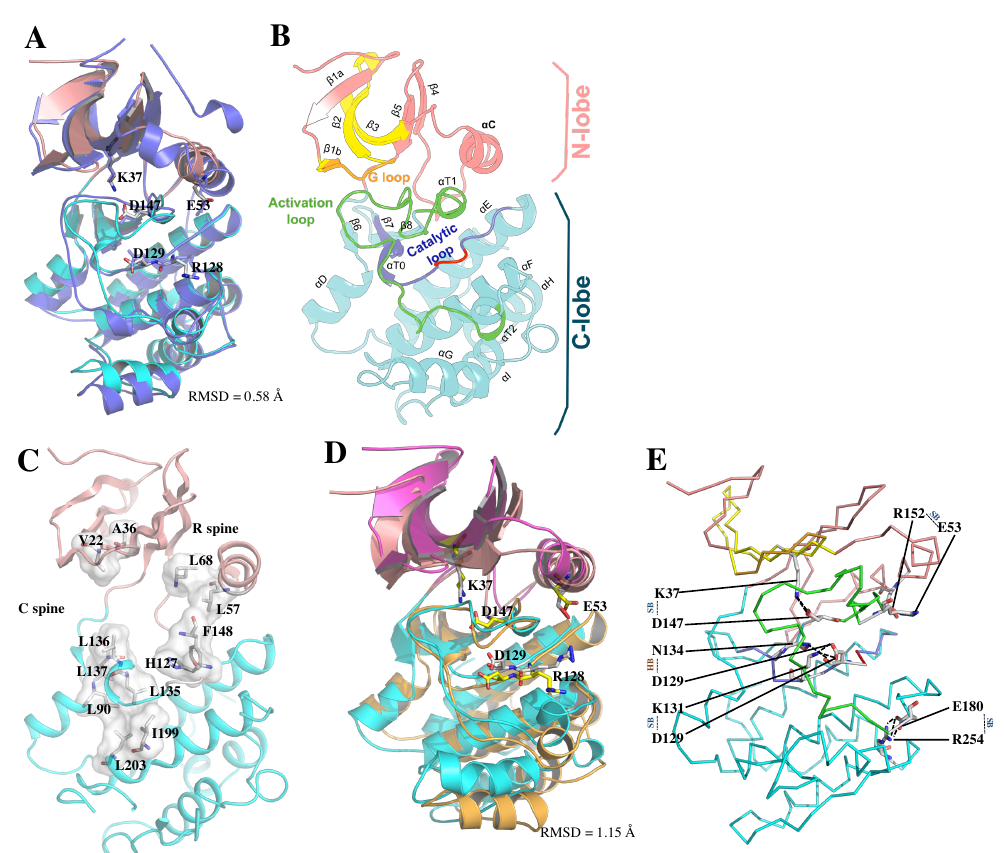
Figure 5. LmJean3 structure evaluation. ( A ) Superposition of the optimized LmJean3 homology model (pink N-lobe and cyan C-lobe) and 4CZT_B (purple) revealed LmJean3 catalytic residues K37, E53, R128, D129, and D147 aligned to their equivalents in the template (4CZT_B). The calculated RMSD was 1.87 Å; ( B ) predicted homology model for LmJean3 showing the ATP-binding region in yellow, glycine-rich loop in orange, activation loop in green, catalytic loop in blue, and catalytic residues R128 and D129 in red; ( C ) molecular surface representation of the catalytic and regulatory spines of LmJean3. The residues forming the spines are displayed as white sticks; ( D ) structure alignment of LmJean3 catalytically relevant residues (K37, E53, R128, D129, and D147) at the initial point of the simulation (magenta N-lobe and orange C-lobe) and the average calculated structure from the trajectory (pink N-lobe and cyan C-lobe). The catalytic residues from the initial frame are colored yellow, and their equivalents from the average structure are colored white. The calculated RMSD was 1.15 Å; ( E ) salt bridges (SB) and hydrogen bonds (HB), with persistence higher than 40% during the trajectory of the molecular dynamics’ simulation are shown in the average